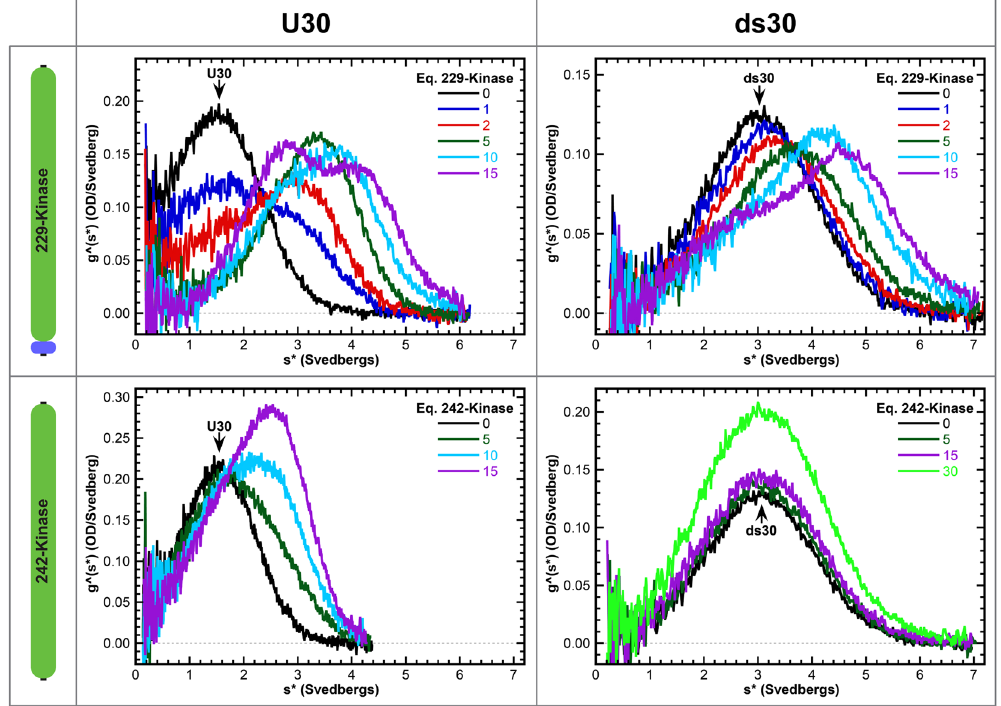
Figure 3. Interaction of the PKR kinase domain/basic region with RNA. Binding of 229-kinase and 242-kinase to U30 and ds30 were analyzed by sedimentation velocity. Measurements were performed in AU75 buffer at 20 °C and 50,000 rpm using absorbance detection at 260 nm. Each panel shows a titration of RNA with protein depicted as a g^(s * ) sedimentation coefficient distribution. Addition of 229-kinase to U30 or ds30 causes a shift in the distributions to the right, indicating complex formation. In contrast, 242-kinase induces only a slight decrease in the peak corresponding to free U30, indicating a very weak interaction. The peak at 2.8 S at higher protein concentrations is due to free 242-kinase. The sedimentation coefficients of 242-kinase and ds30 are similar and the increase in the peak amplitude is primarily due to free protein. 229-kinase data were fit to a sequential 2:1 binding model and 242-kinase data were fit to a 1:1 binding model to extract the binding parameters displayed in Table